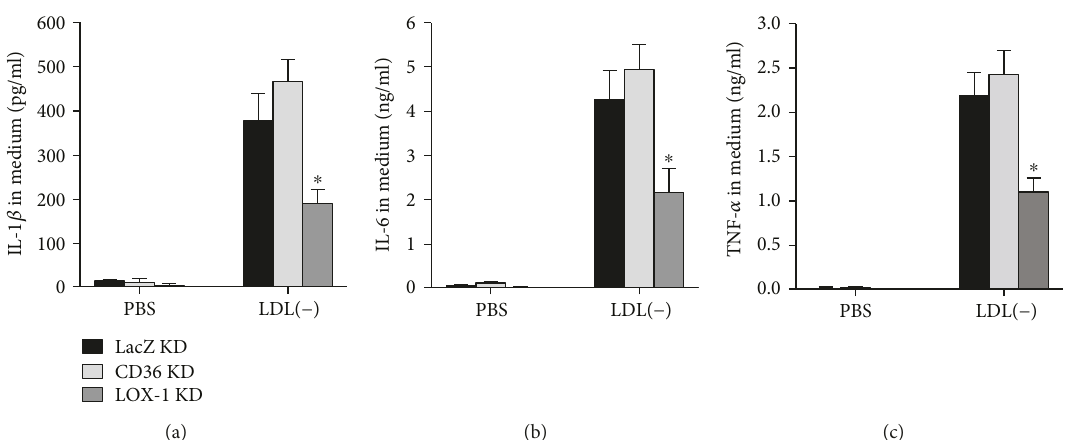
Figure 4: Knockdown of lectin-type oxidized LDL receptor (LOX-1) decreased LDL(-)-induced production of IL-1 β , IL-6, and TNF- α . LOX- 1-, CD36-, or LacZ-knockdown (KD) cells were generated as described previously [5, 21]. Knockdown cells were incubated with PBS or 20mg/ml LDL(-) for 24h. Levels of IL-1 β (a), IL-6 (b), and TNF- α (c) in the medium were determined. Values are the mean ± SD of three independent experiments. ∗ p < 0 05 , compared to CD36- or LacZ-KD cells.